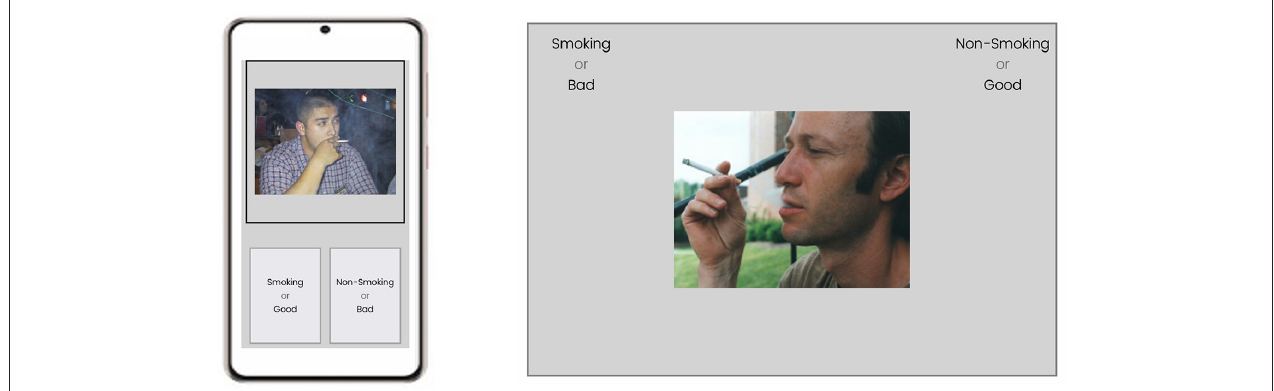
FIGURE 6 | A schematic representation of a trial in the implicit association test experiment running a smartphone (left) and on a desktop computer (right) . IAT, Implicit Association